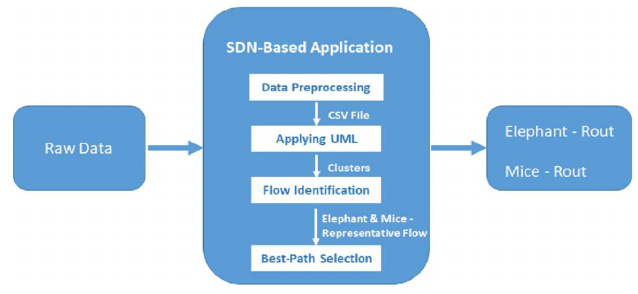
Figure 1. Proposed Methodology.